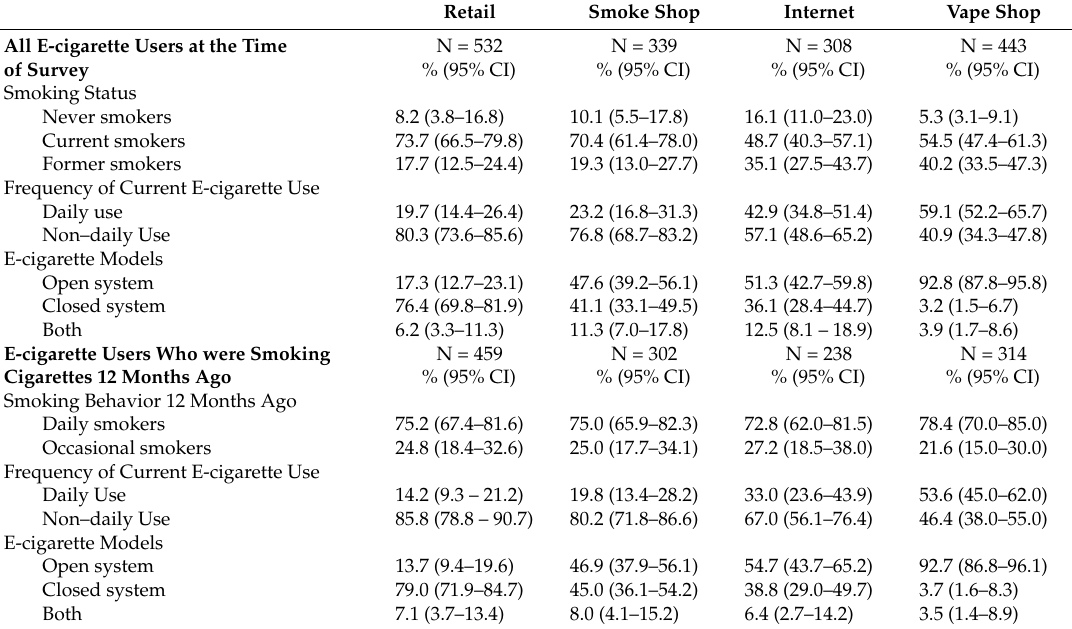
Table 2. Cigarette smoking behavior and the use of e-cigarette systems (2014 and 2016 surveys